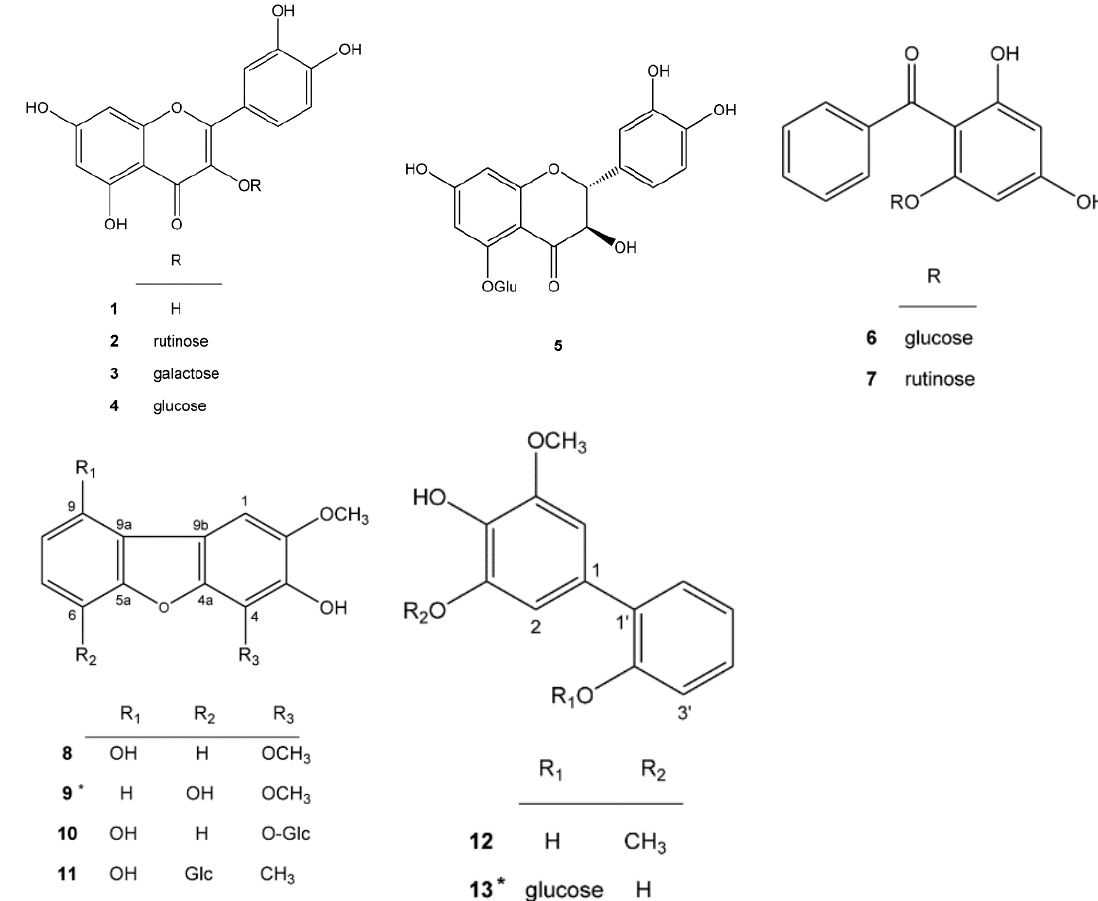
Figure 1. Structures of compounds isolated from P. koidzumii . (* new compound).